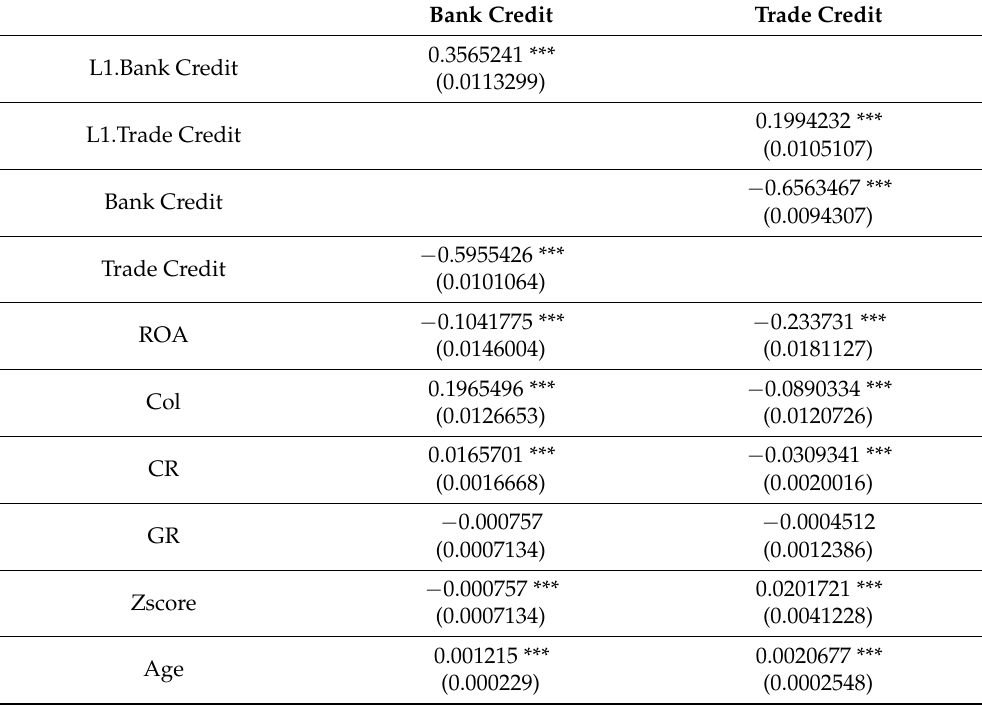
Table 8. Arellano–Bond linear dynamic